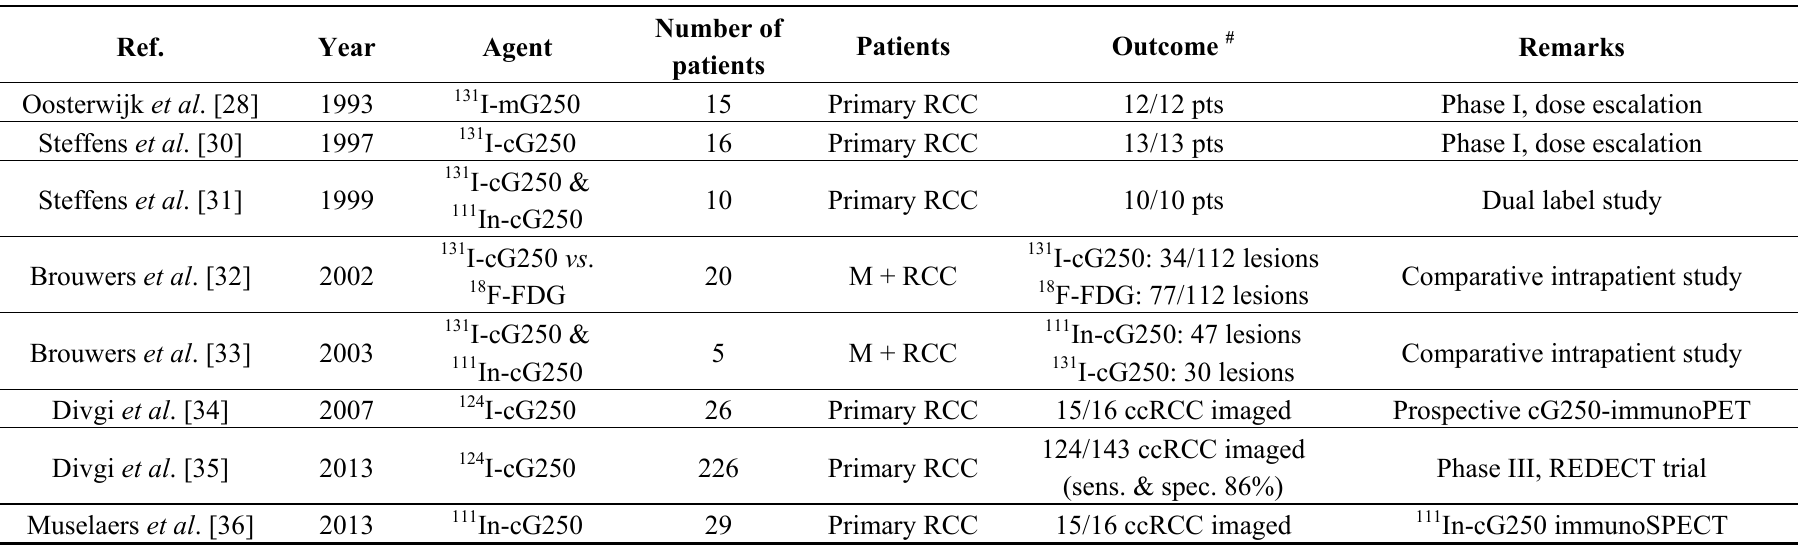
Table 1. Overview of Imaging studies with mAbG250 in RCC